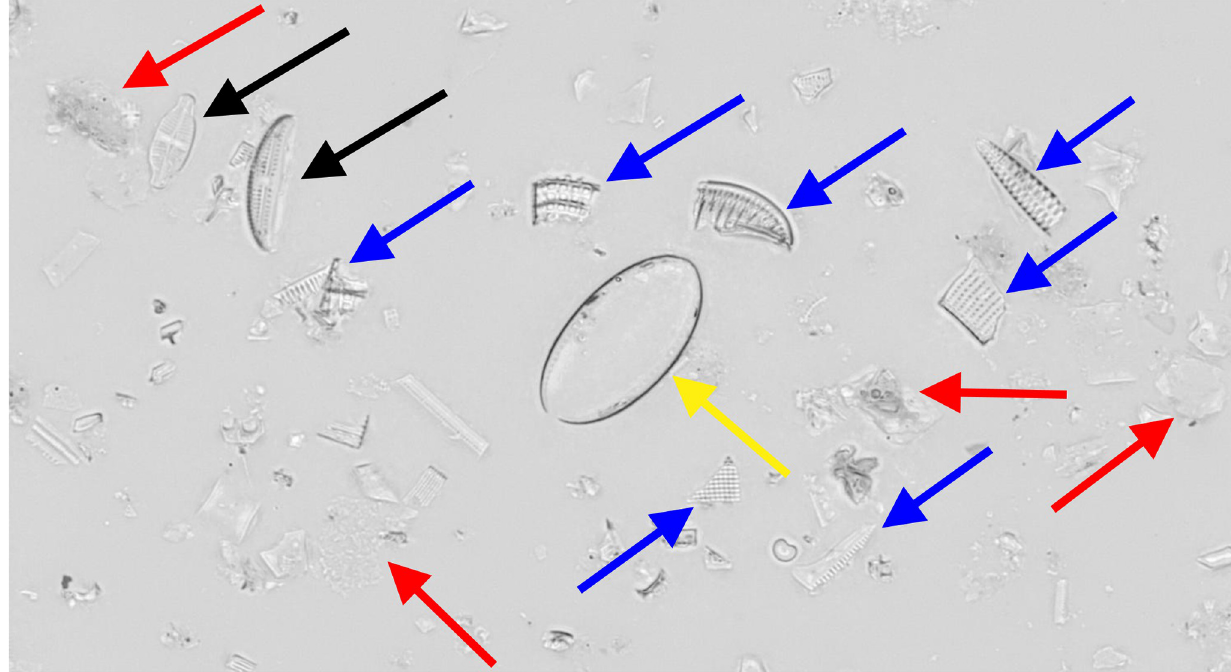
Fig 2. Small subsection of a virtual slide image, containing relevant, (mostly) intact diatom objects (black arrows) as well as irrelevant small diatom fragments (blue) and girdle bands (yellow) and also non-diatom debris like silt or clay particles (red).